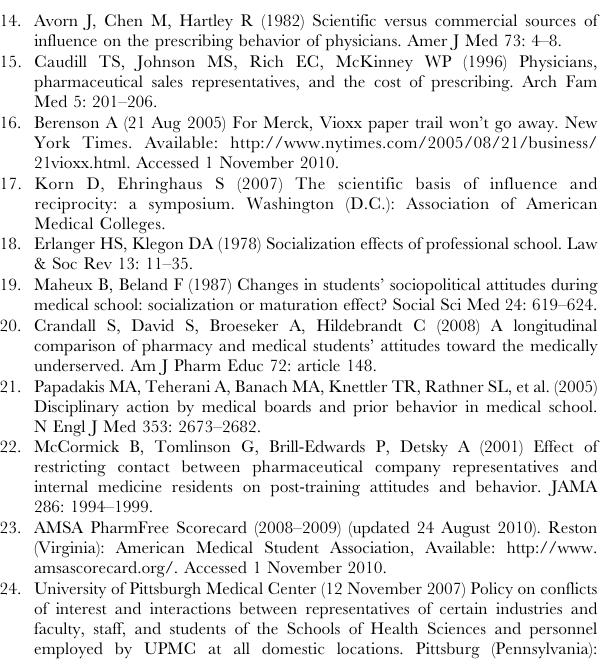
Table S1 Systematic review search strategy. The follow- ing search strategy was employed for searching PubMed and was adapted for other database; MeSH, medical subject